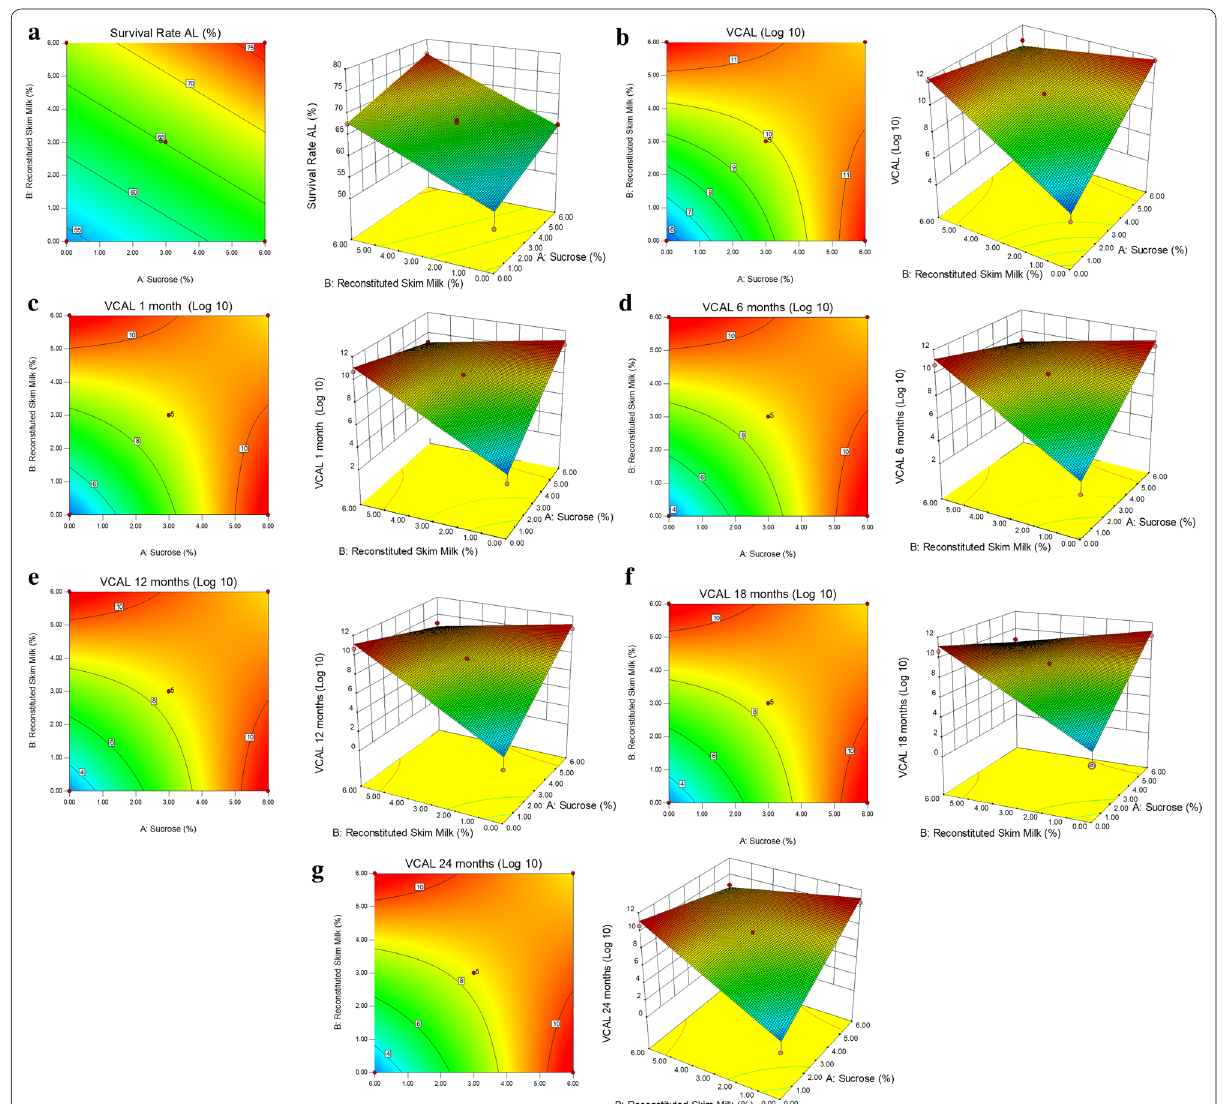
Fig. 2 Response surface (right) and contour (left) plots depicting effect of sucrose and reconstituted skim milk on a survival rate (%), log 10 CFU/mL values obtained in b viable count after lyophilization [VCAL], c VCAL 1 month, d VCAL 6 months, e VCAL 12 months, f VCAL 18 months and g VCAL 24 months lyophilized probiotics